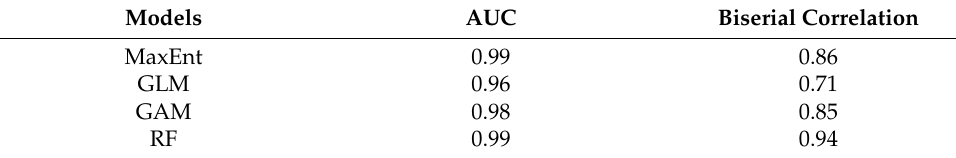
Table 2. AUC and biserial correlation scores of all modeling